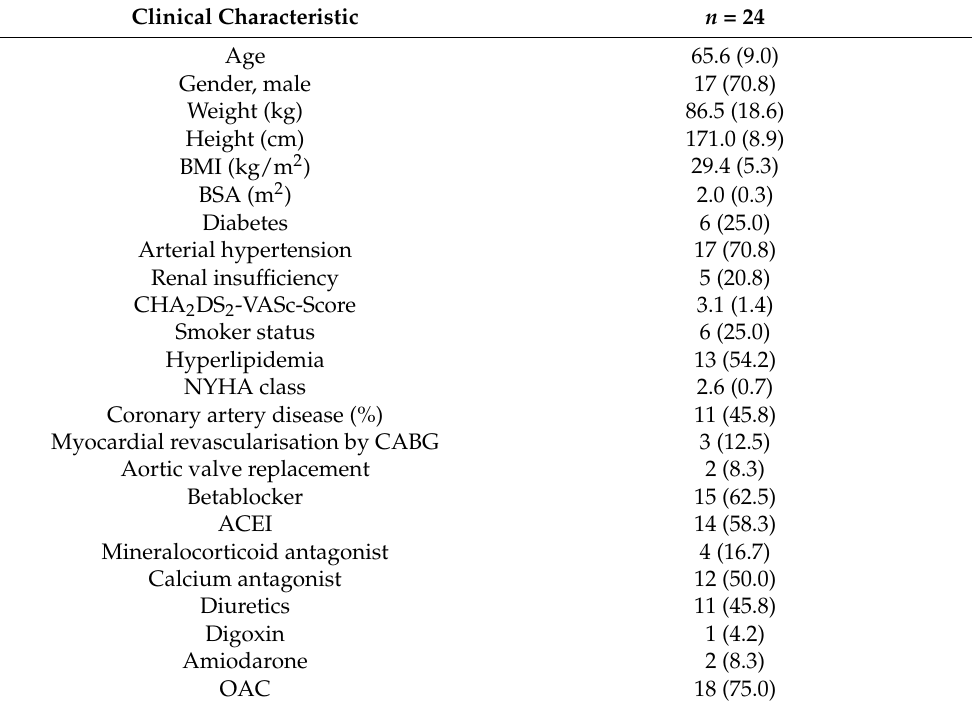
Table 1. Clinical Baseline